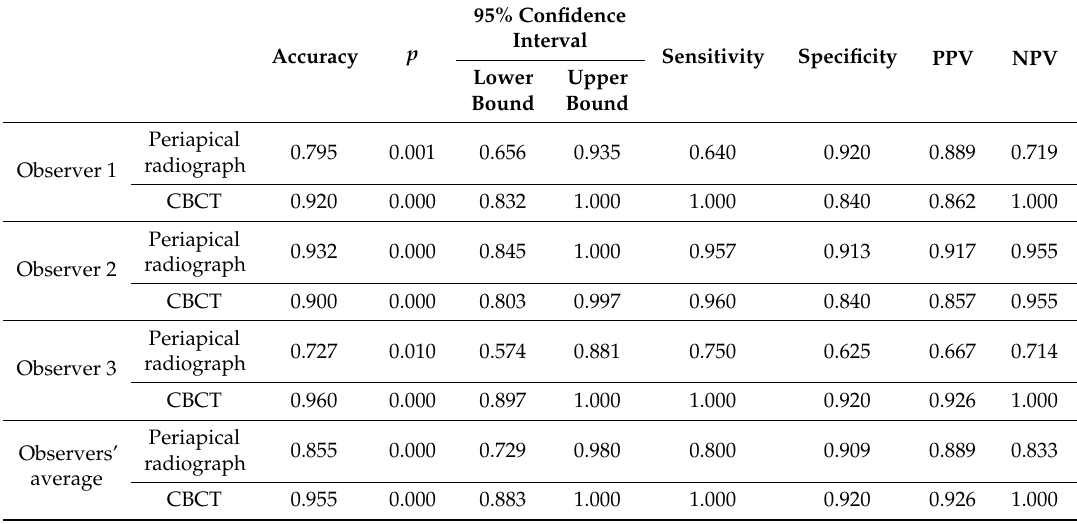
Table 2. Accuracy, sensitivity, specificity, PPV, and NPV values for each observer and observers’ average in detecting strip perforation (group